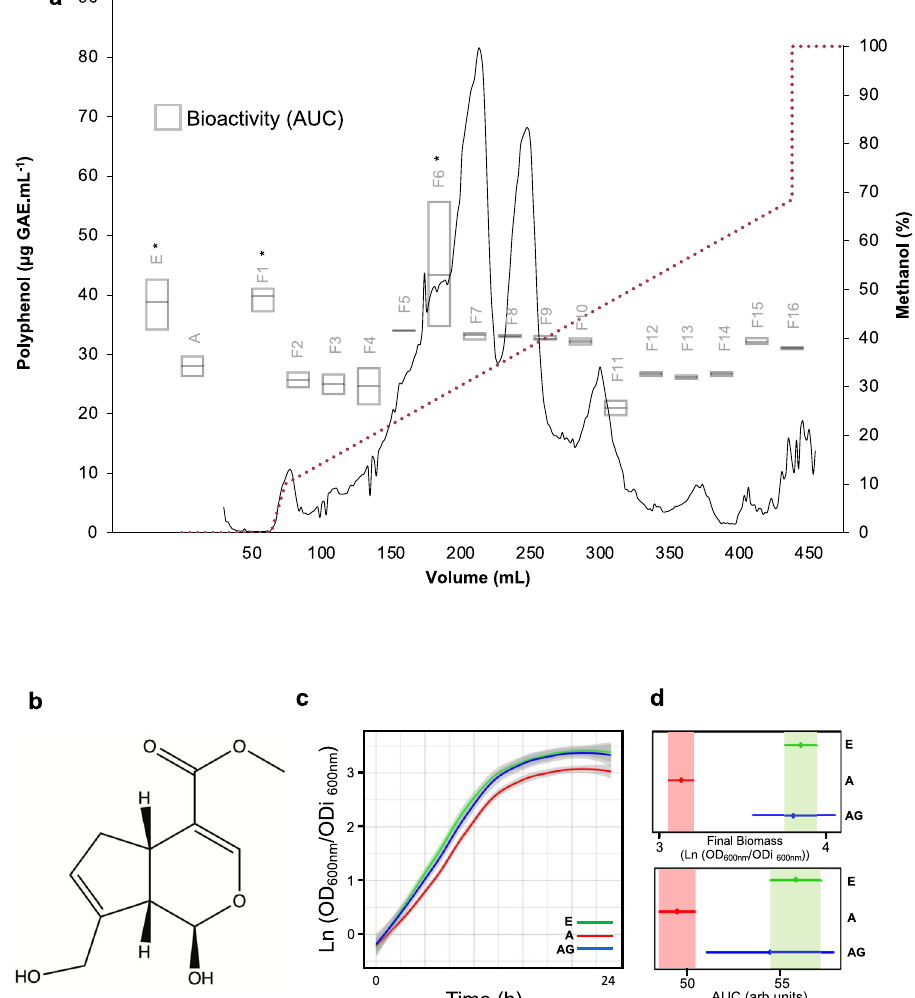
Fig. 1 | Bioguided fractionation of Corema album L. leaf PEF extract identi fi es genipin derivatives as the bioactive compounds. a PEF was fractionated by LC with a methanol gradient (pointed purple line, right y-axis). The chromatogram was obtained by quanti fi cation of total phenols (dashed gray line, left y-axis; μ g GAE.mL -1 :gallicacidequivalent permL)forthefractionsof C.album .L.Atotalof16 fractionswereobtainedandtestedintheyeastPDmodel.Controlcellscarryingthe empty vector and cells expressing two copies of α Syn-GFP were incubated